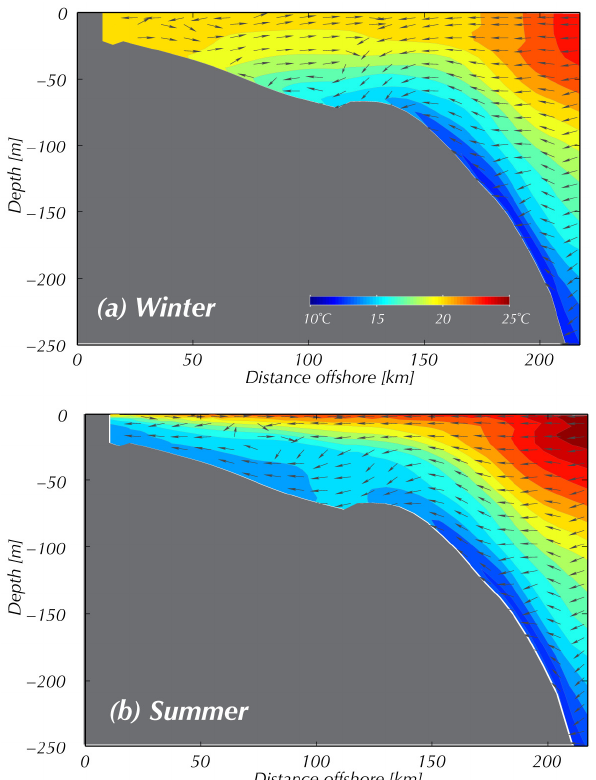
Fig. 3. Temperature and cross-shelf circulation at cross-section C from EXP1. (a) Winter, (b) Summer.